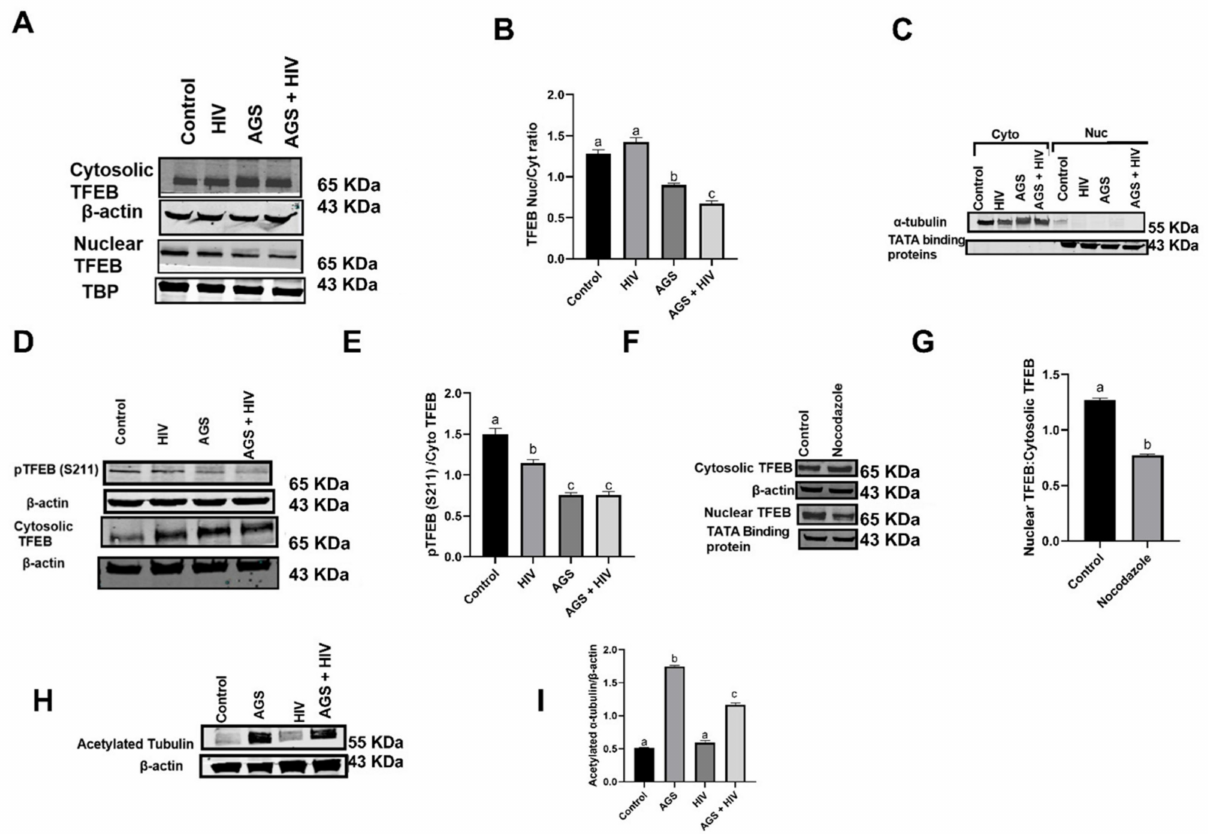
Figure 5. Suppression by AGS and HIV of transcription factor EB (TFEB) protein expression in cytosolic and nuclear fractions of RLW cells. ( A ) nuclear and cytosolic TFEB protein expressions were measured by immunoblot analysis. Equal (20 µ g) amounts of protein were loaded in each lane. β -actin and TATA-binding proteins (TBP) were used as internal controls. ( B ) Quantification of nuclear and cytosolic TFEB ratios from 3 independent experiments. ( C ) Immunoblot analysis to confirm the purity of cytosolic and nuclear fractions. Equal amounts of cytosolic and nuclear proteins were loaded onto gels and blotted onto nitrocellulose. α -tubulin was checked in nuclear fractions and TBP in cytosolic fractions. ( D ) Immunoblotting analysis of phospho TFEB serine 211 protein expressions. Equal (20 µ g) amounts of protein were loaded in each lane. β -actin and total TFEB were used as an internal control. ( E ) Quantification of serine 211 phosphorylation/total TFEB ratios. Data are from 3 independent experiments, presented as the mean ± SEM. Bars marked with the same letter are not significantly different from each other; bars with different letters are significantly different ( p ≤ 0.05). ( F ) Nuclear and cytosolic TFEB was measured by immunoblotting analysis. Equal (20 µ g) amounts of protein were loaded in each lane. β -actin and TBP were used as an internal control ( G ) Quantification of nuclear to cytosolic TFEB ratios from 3 independent experiments. ( H , I ) Acetylated tubulin was measured by immunoblot analysis and quantification of protein bands from 3 independent experiments. Data are from 3 independent experiments presented as mean ± SEM. Bars marked with the same letter are not significantly different from each other; bars with different letters are significantly different ( p ≤